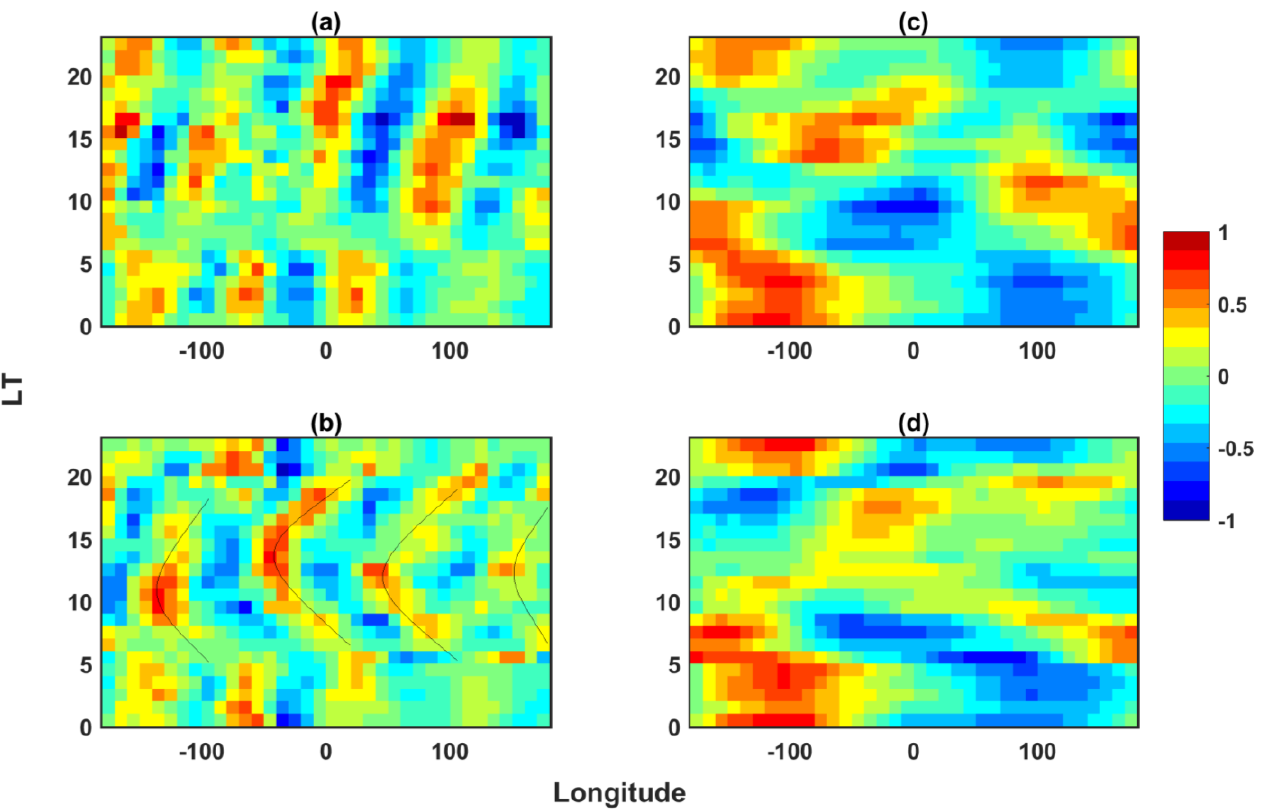
Figure 6. ( a , b ) Local-time variation of WN4 component of normalized electron density at 302.5 km altitude over the EIA crest (panel a ) and trough (panel b ) regions. ( c , d ) Local-time variation of WN4-filtered (residual) component of normalized electron density at 302.5 km altitude over the EIA crest (panel c ) and trough (panel d ) regions.